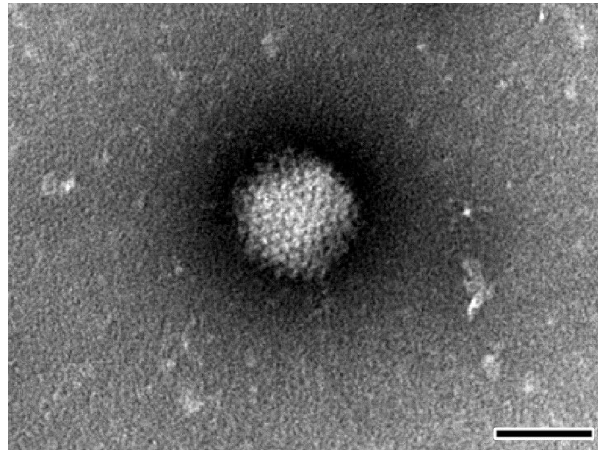
Figure 2. Transmission electron micrograph of negatively stained adenovirus from NPU cell culture suspension. The size and appearance of the viral particles are characteristics for the Adenoviridae family. Scale bar: 50